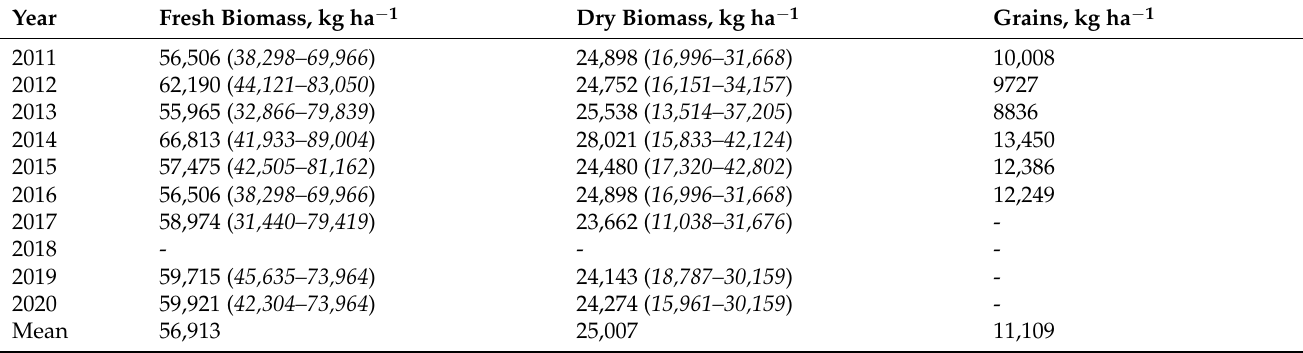
Table 6. Yield of fresh, dry biomass, and grains (mean/min–max) of corn crops cultivated for silage in the state of Paran á , Brazil in ten summer crops (2011–2020).